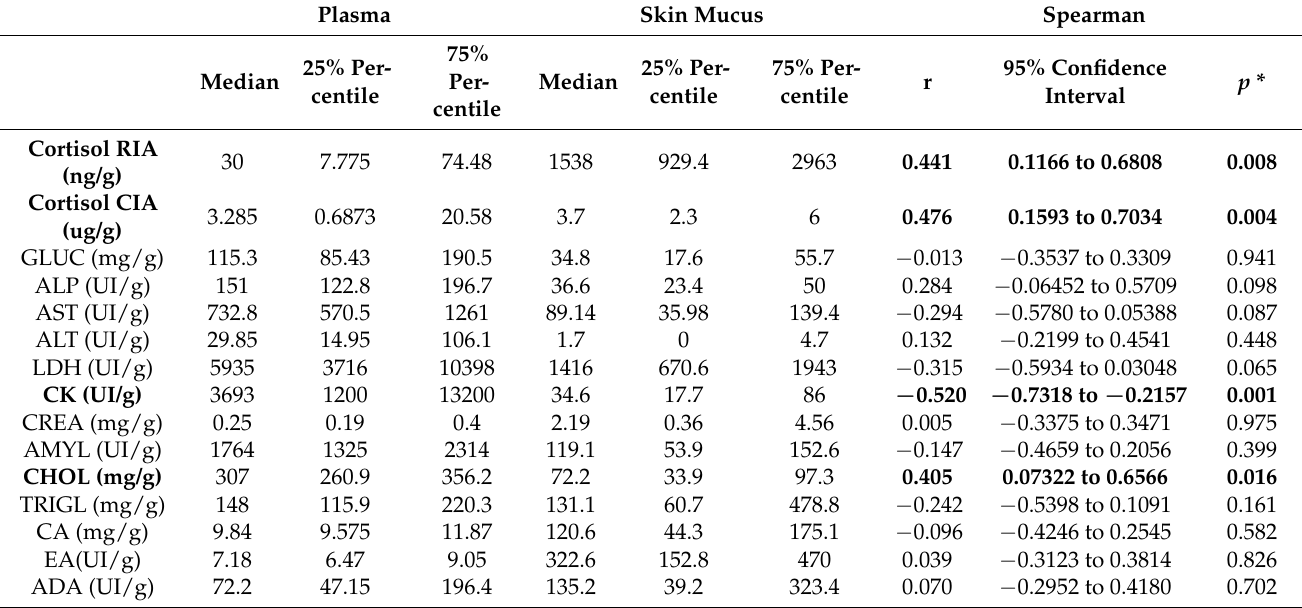
Table 2. Spearman correlation for each biomarker, between plasma and skin mucus, of glucose (GLUC), alkaline phosphatase (ALP), aspartate transaminase (AST), alanine aminotransferase (ALT), lactate dehydrogenase (LDH), creatinine kinase (CK), creatinine (CREA), amylase (AMYL), cholesterol (CHOL), triglycerides (TRIGL), calcium (CA), esterase activity (EA), and adenosine deaminase (ADA). * In bold statistically significant differences after applying the False Discovery Rate following the Benjamini and Hochberg method ( p < 0.05). Plasma Skin Mucus